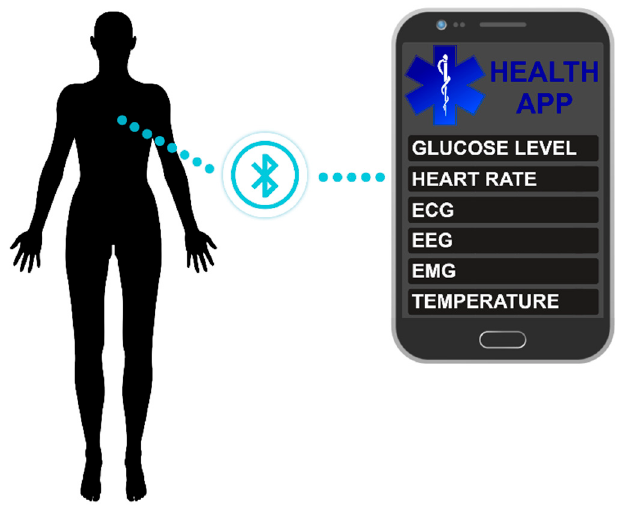
Figure 6. A selection of possible applications of CNTs sensors in smart textiles for health monitoring.